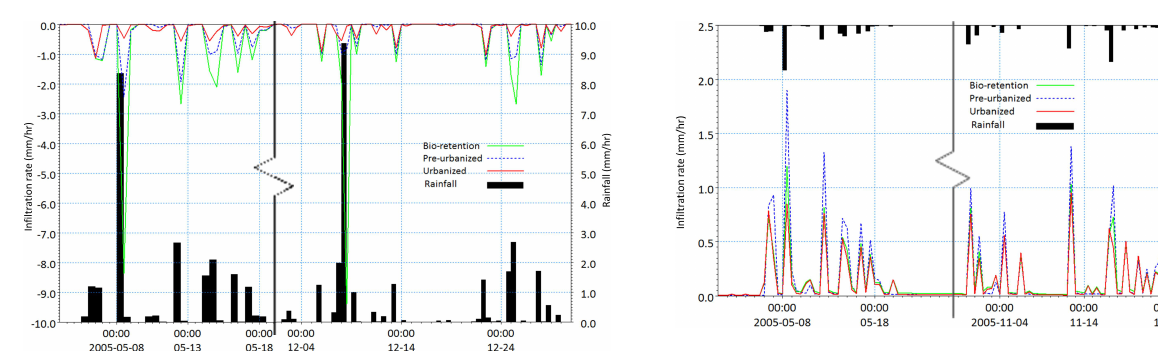
Fig. 8. Infiltration rate at observation point (indicated in Fig. 2) in catchment.